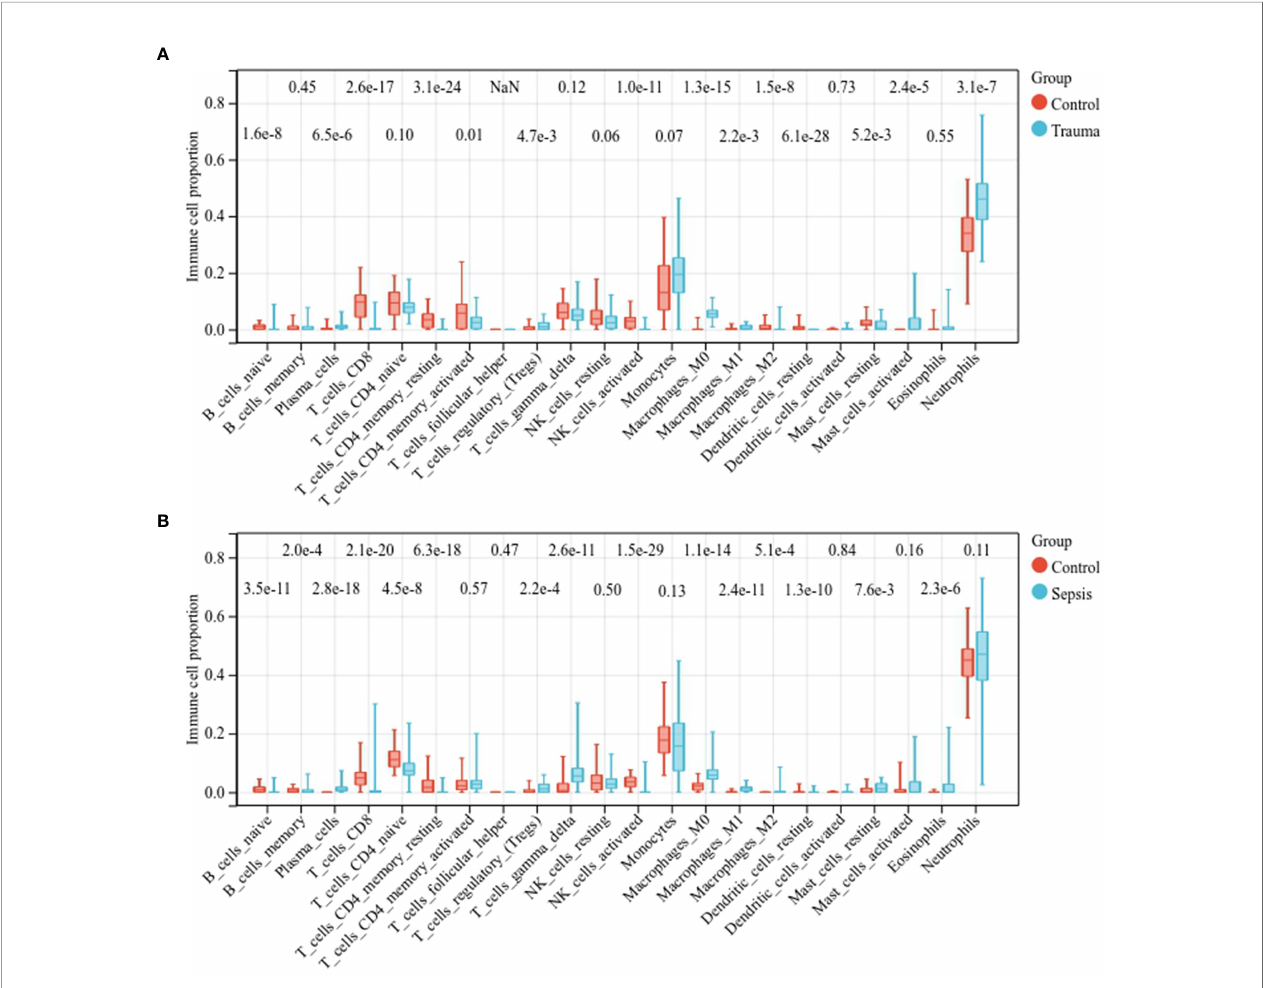
FIGURE 2 | Comparison of the immune cell fractions. Comparison of immune cell fractions between (A) healthy controls and trauma patients and (B) healthy controls and sepsis